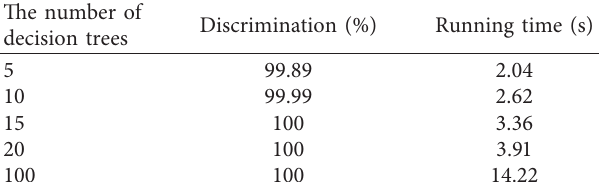
Table 2: Load types.